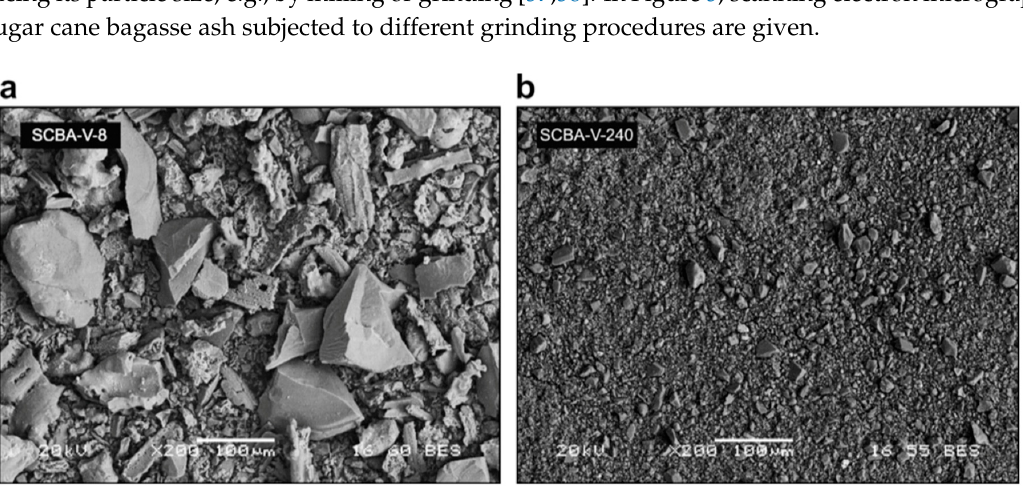
Figure 5. SEM images of sugarcane bagasse ashes (SCBAs) produced after 8 min ( a ) and 240 min ( b ) of vibratory grinding [57].